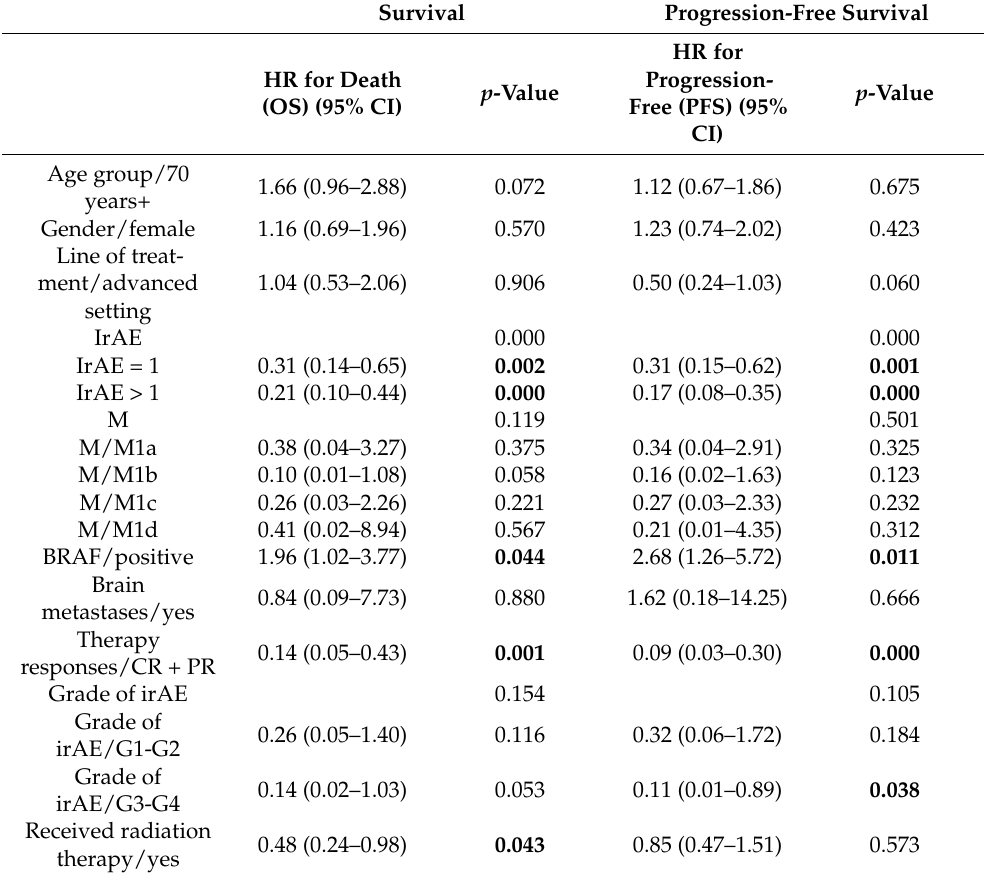
Table 5. Cox regression analysis of the